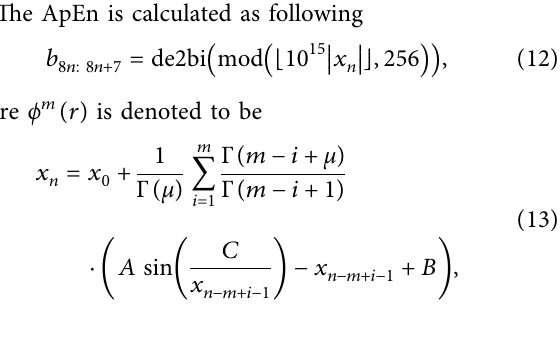
� 0 . 1 for the blue diagram and x � − 0 . 1 for the red 0 0